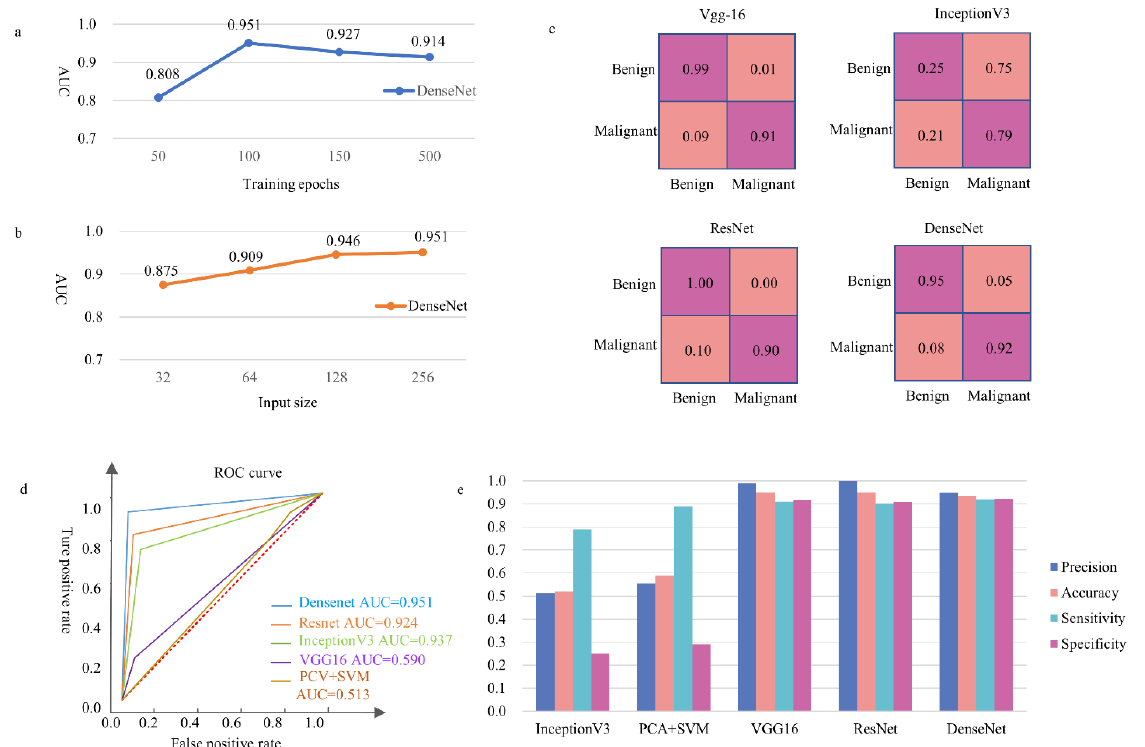
Figure 5. The performance of our model and four other common DL models on the same validation set. ( a ) Description of the AUC corresponding to the network with different numbers of iterations. ( b ) Description of the AUC corresponding to the network with different image input sizes. ( c ) The confusion matrix of different networks under the same hyperparameter conditions. The horizontal axis was a true label, the vertical axis was the predicted label, and the lower false-negative rate was preferred. ( d ) The ROC curves of different models. ( e ) The precision, accuracy, sensitivity, and specificity of different models.